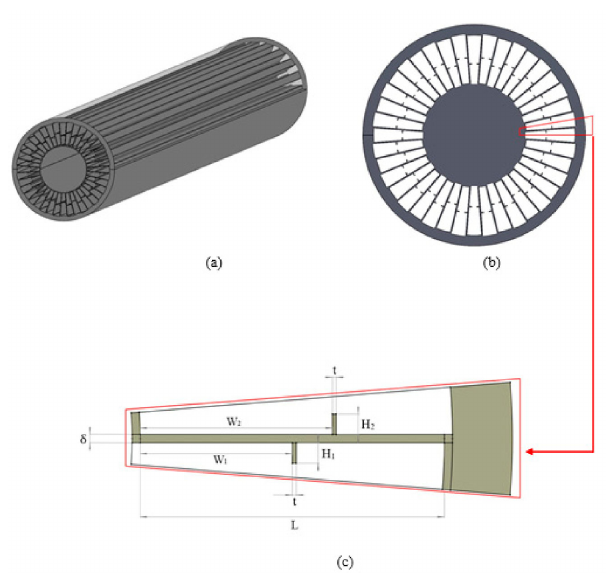
Figure 4. The physical model of design B PTHE-ZR. ( a ) three-dimensional view, ( b ) cross-sectional view and ( c ) computational